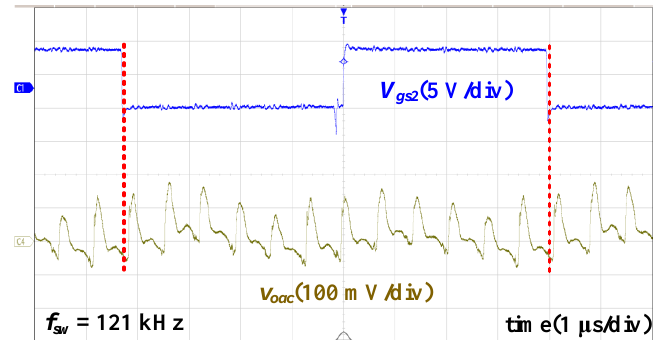
Figure 25. Output ripple voltage waveform at a 100% load.